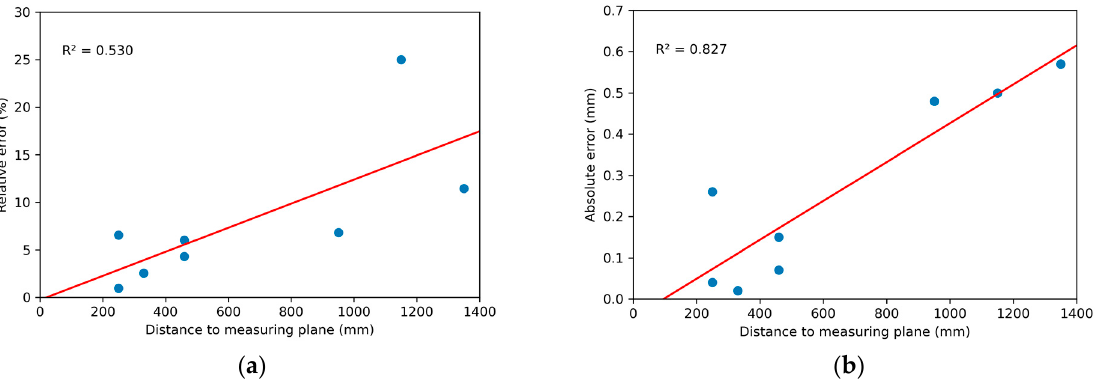
Figure 6. ( a ) Effect of distance to measuring plane on the relative error; ( b ) Effect of distance to measuring plane on the absolute error.